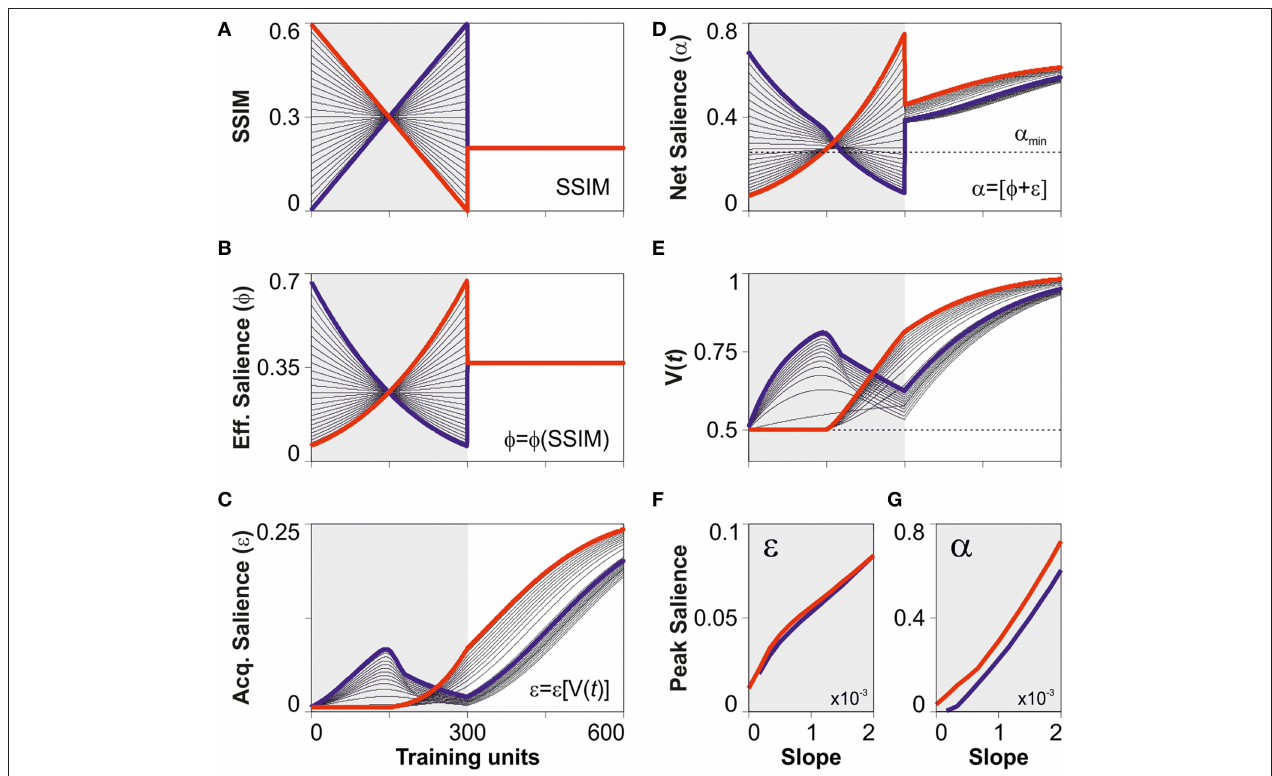
FIGURE 5 | Differences in peak salience for training programs with identical stimuli. (A) Synthetic creation of SSIM training programs consisting of a variable SSIM epoch followed by a constant one. The first, “variable” epoch (from trial 1 to 300) was created using linear ramps with positive (blue) and negative (red) SSIM slopes. (B) These arrangements consist of the same stimuli, sorted in ascending (blue) or descending (red) order, respectively. The second, “constant” epoch (trials 301–600) consisted of training with the same constant SSIM, one that led to a net salience α (SSIM) > α min . Solving Equation (7) (see Materials and Methods) we display the effective (B) , acquired (C) , and net (D) salience. To simulate discriminative training, we took the optimized parameters from the best predictive model displayed in Figure 2D (“bound” salience; green dotted line) and numerically solved Equation (1) (see Materials and Methods). We illustrate the predicted learning curves in panel (E) . The overall differences in the learning curves can be explained by the differences in net (G) but not in acquired (F) peak salience during